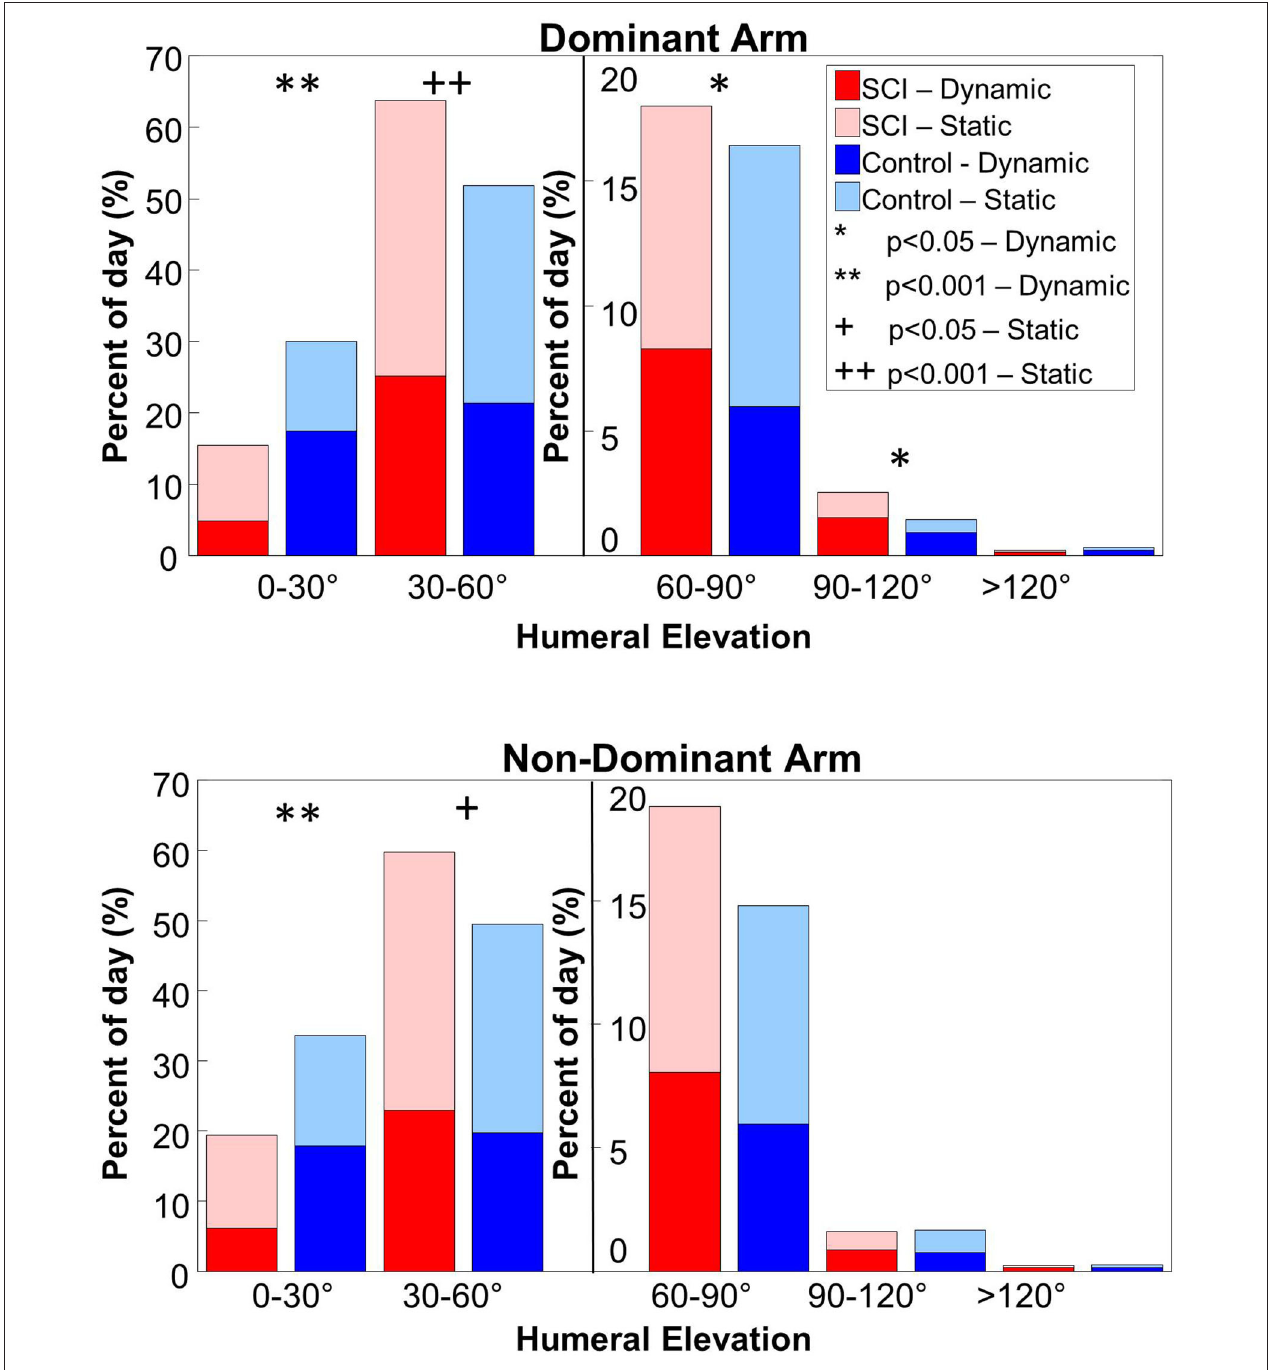
FIGURE 2 | The percent of the day the MWC (red colors) and control (blue colors) cohorts spent static and dynamic in each humeral elevation range for the dominant (top pane) and non-dominant (bottom pane) arms. The lighter colors indicate static time and the darker colors indicate dynamic time. A secondary y-axis is used for humeral elevations over 60 ◦ to more clearly show the differences and similarities between cohorts. Analyses were conducted between the MWC and control cohorts for the static periods ( + indicates p < 0.05 and ++ indicates p < 0.001) and dynamic periods (* indicates p < 0.05 and ** indicates p < 0.001).